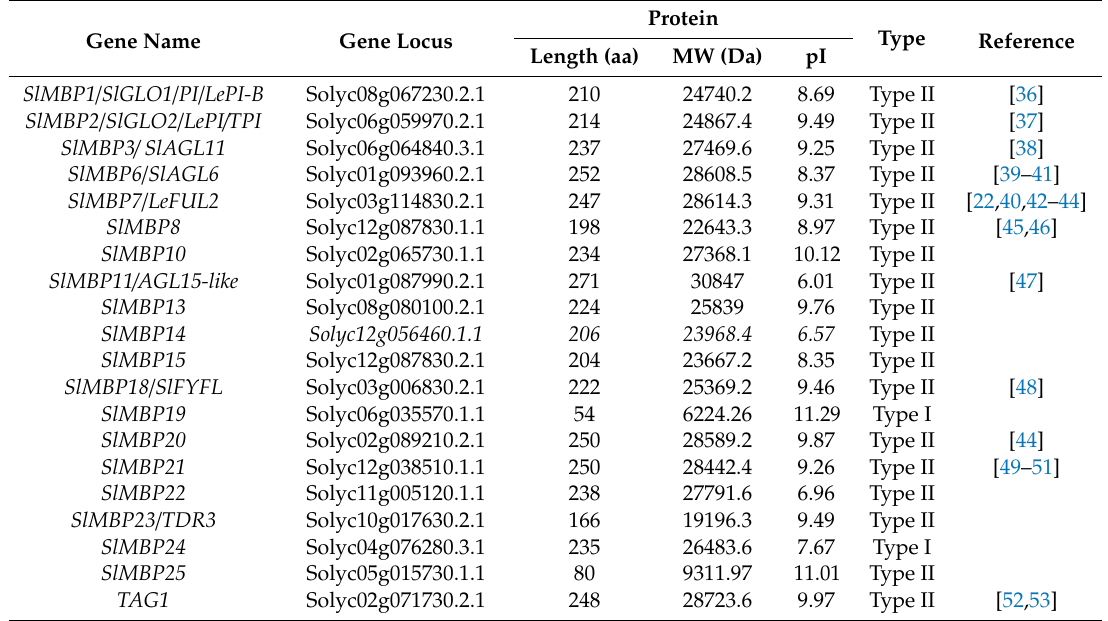
Table 1. Overview of MADS-box genes identified in tomato. List of predicted genes and related information include gene name, gene locus, molecular details, classification of two types according to the phylogenetic analysis shown in Figure S1, homologs in Arabidopsis, as well as the reference of the gene function investigation. pI, isoelectric point; MW, molecular